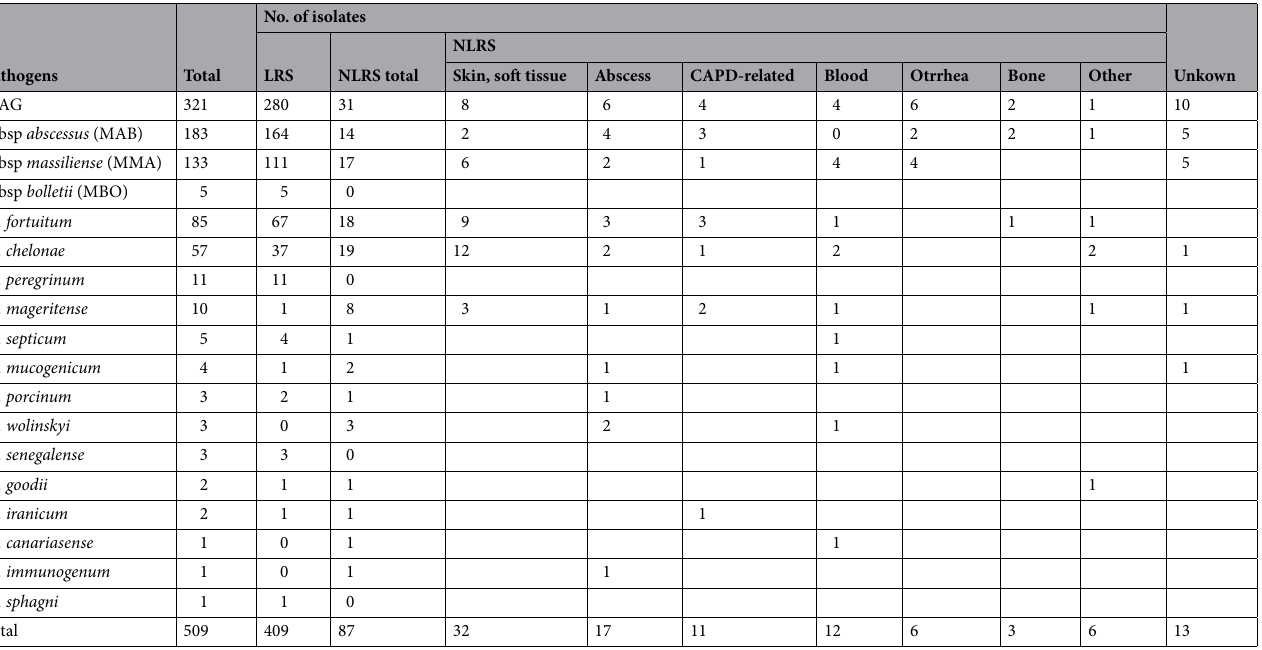
Table 1. Distribution of rapidly growing mycobacteria (RGM) species by specimen type. PD Peritoneal dialysis, LRS lower respiratory specimens, NLRS non-lower respiratory